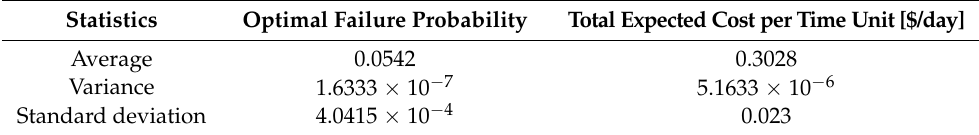
Table 2. Results obtained in the maintenance cost optimization.